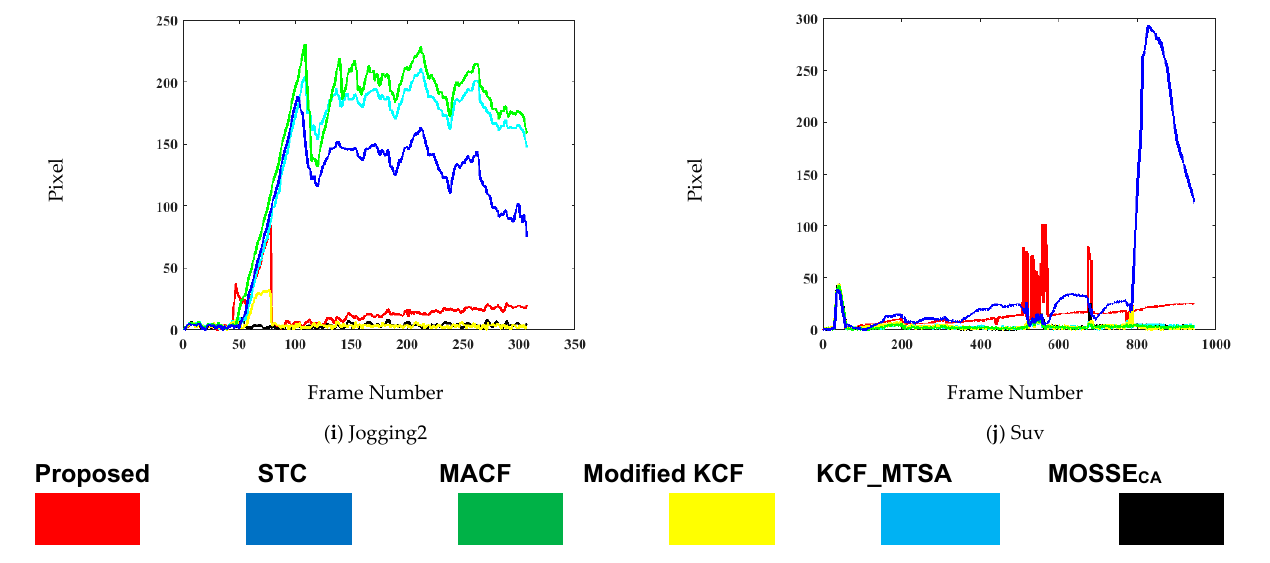
Figure 7. Center location error (in pixels) comparison for the OTB-100 dataset [26]. Frames per second (fps) analysis is presented in Table 3. In the Blurcar1, Car2, Dancer2, Human7, and Jogging1 videos, the proposed algorithm outperforms Modified KCF, MOSSE CA , MACF, KCF_MTSA, and STC in terms of precision in error at the expense of modest frame rate. Table 3. Frames per second (fps).